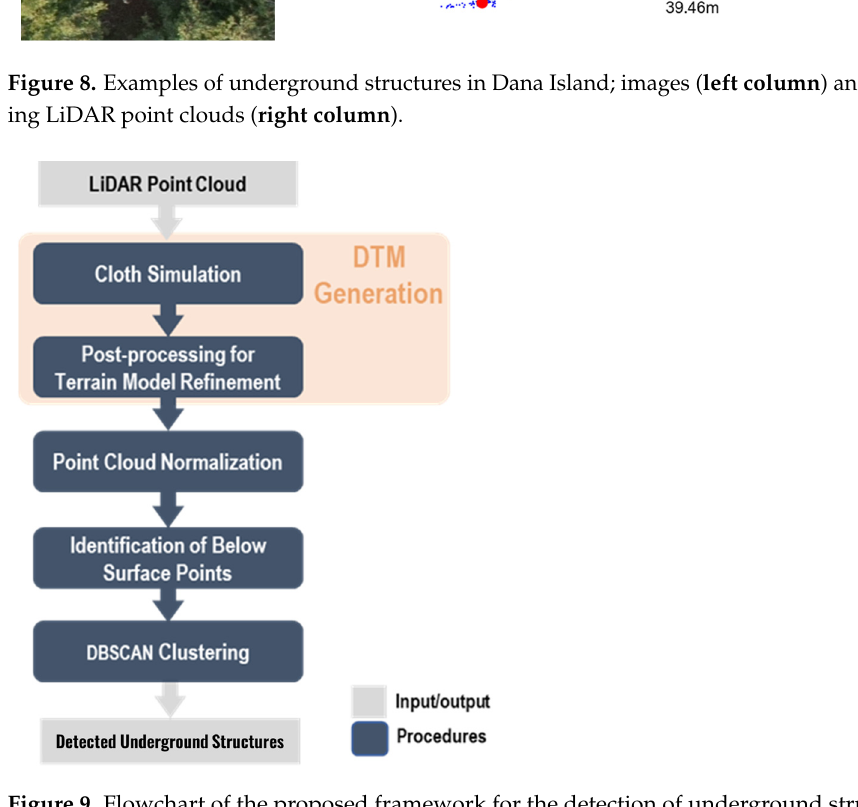
Figure 9. Flowchart of the proposed framework for the detection of underground structures using UAV LiDAR point clouds.